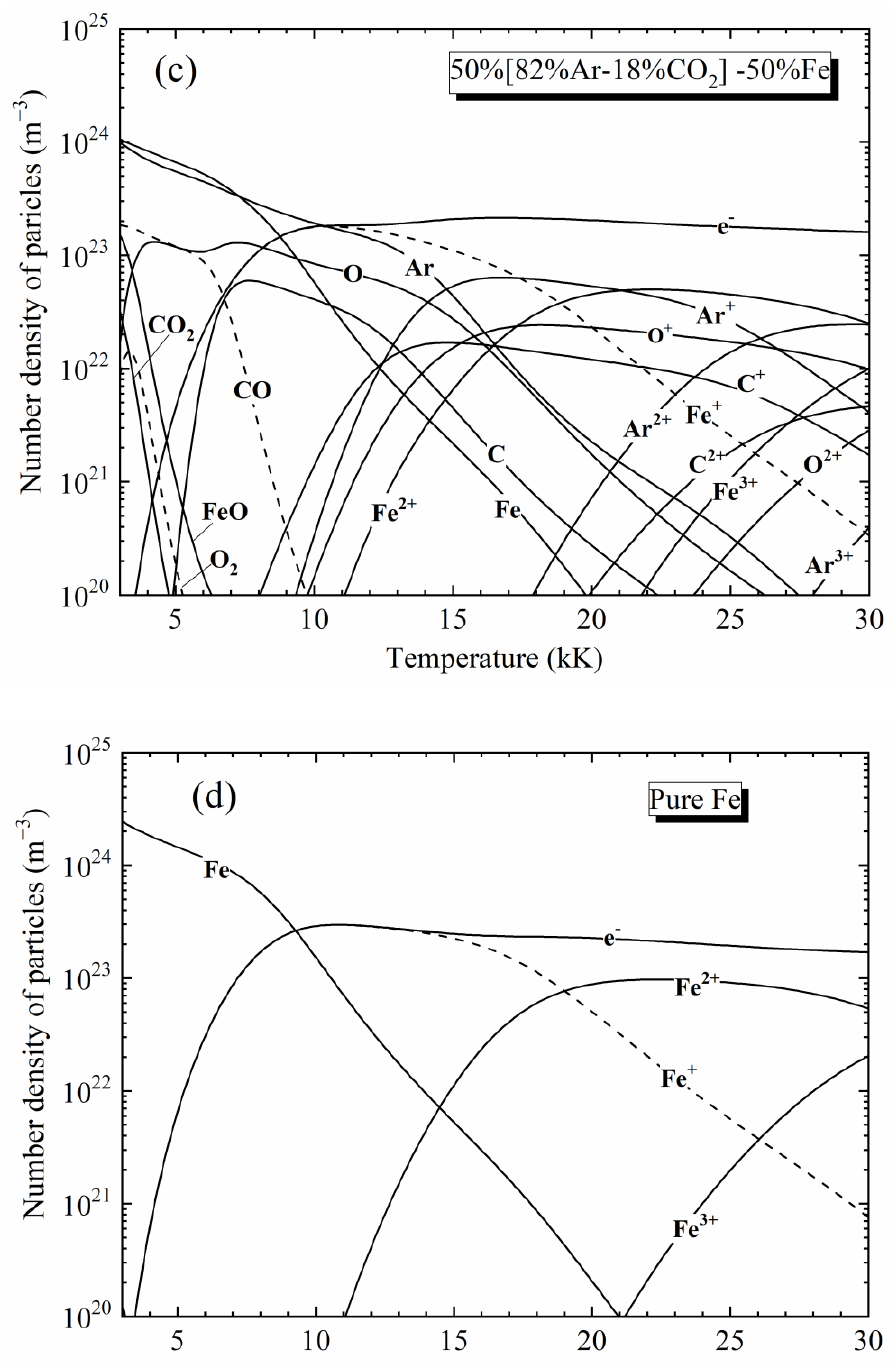
Figure 1. Equilibrium composition of some [82%Ar-18%CO 2 ]-Fe mixtures (molar proportion) at 0.1 MPa: ( a ) 82%Ar-18%CO 2 ; ( b ) 90%[82%Ar-18%CO 2 ]-10%Fe; ( c ) 50%[82%Ar-18%CO 2 ]-50%Fe; and ( d ) Pure Fe.